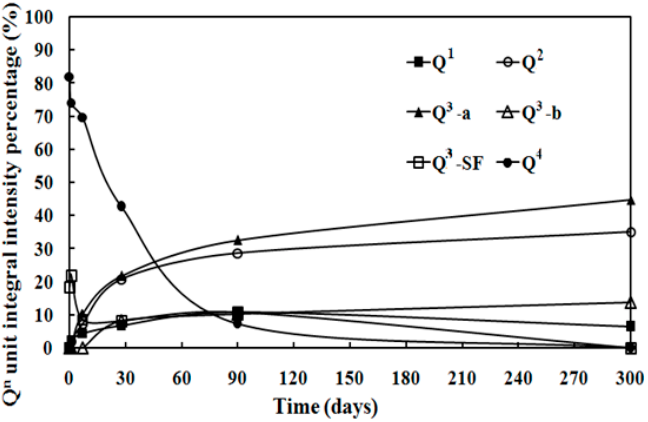
Figure 6. Q n unit integral intensity percentage of the MSH samples via 29 Si MAS NMR spectra for different curing time.